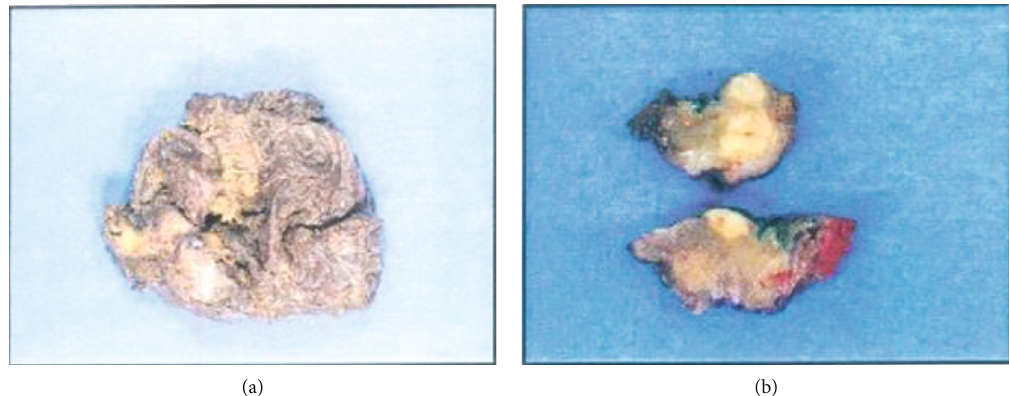
Figure 2: Macroscopy examination: (a) right breast capsulectomy with a mass of 47 g and (b) left breast capsulectomy and implant